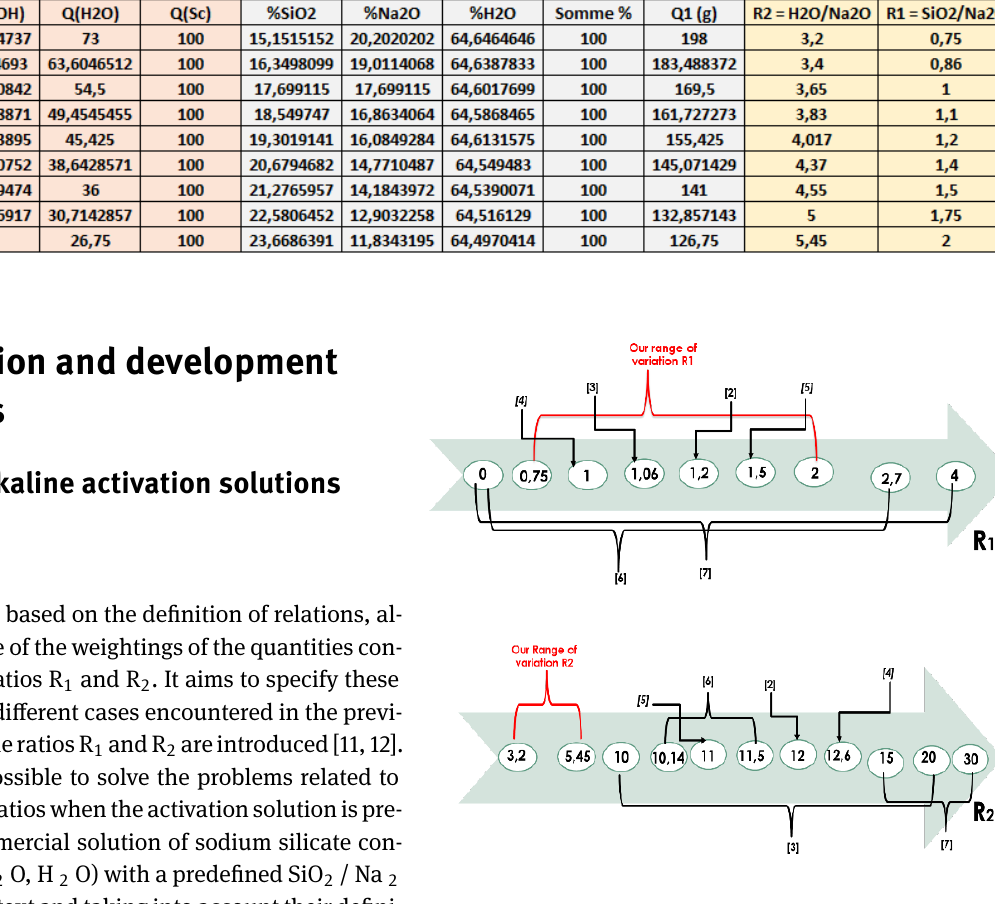
Figure 2: Position of our study in relation to the